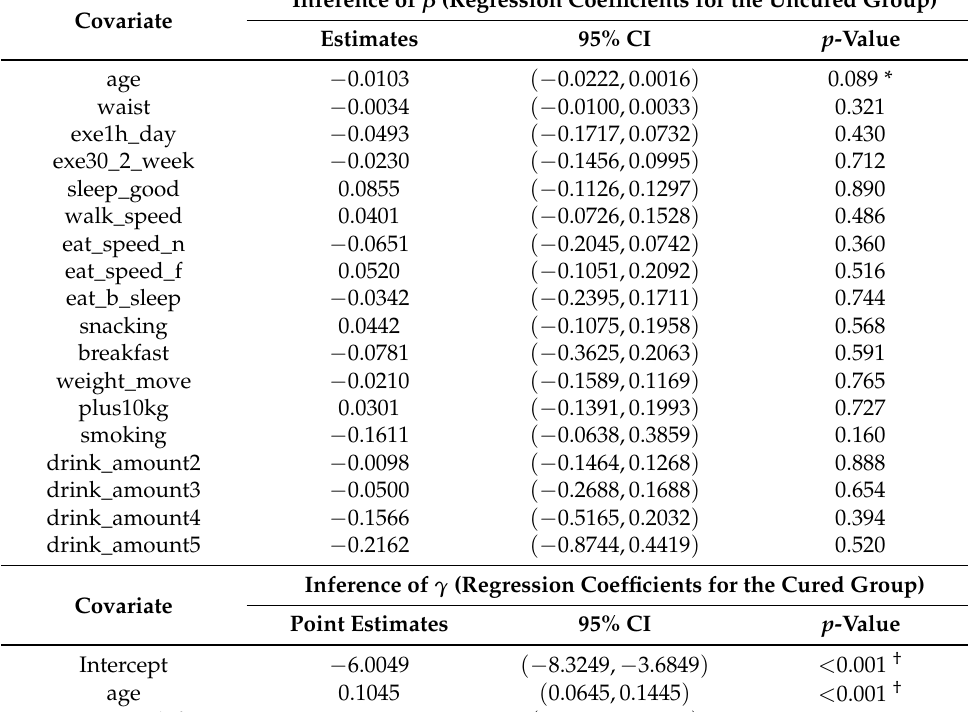
Table 8. Estimation result of regression coefficient when variable selection is performed by applying the proposed model in females. CI is the confidence interval. The asterisk (*) and dagger (†) indicate that p -value is less than 0.10 and 0.05, respectively.